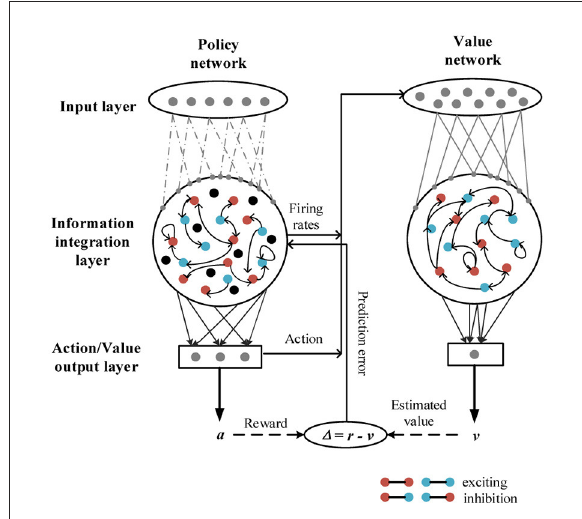
FIGURE1 Structures of the neural network model. The deep RL neural network model, consisting of a policy network and a value network. In the policy network, sparse connections are made from the input layer to the information integration layer (IIL), among neurons in the IIL. Full connections are made from the IIL to the action output layer. In the value network, full connections are made among neurons in the input layer, the IIL, and the value output layer. In addition, in the IIL, red-red or blue-blue indicates excitatory connections between neurons; red-blue or blue-red indicates inhibitory connections between neurons; and black indicates no connection between neurons.